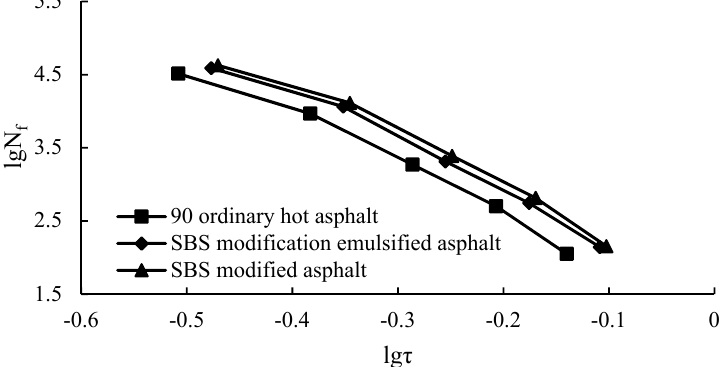
Figure 12. Relationship between fatigue life and stress ratio for different waterproof cohesive layer materials.